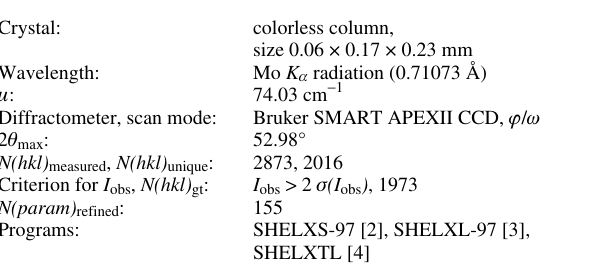
Table 1. Data collection and handling.